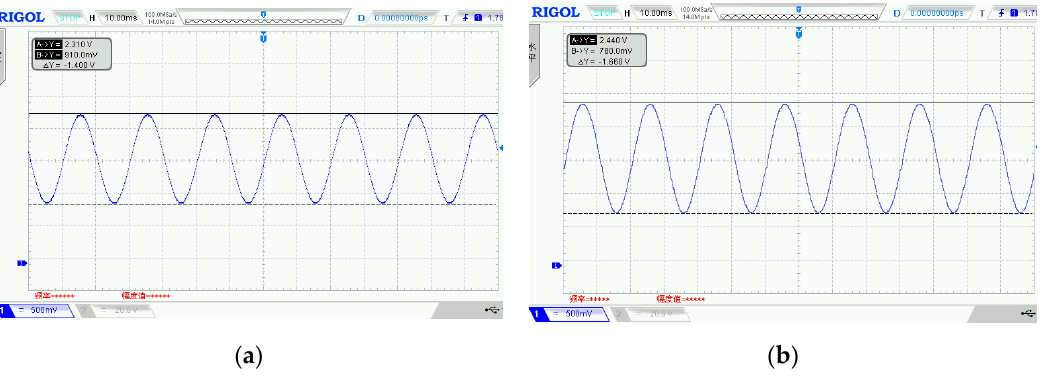
Figure 8. Experimental test results of the signal conditioning circuit: ( a ) voltage transducer; and ( b ) current transducer.